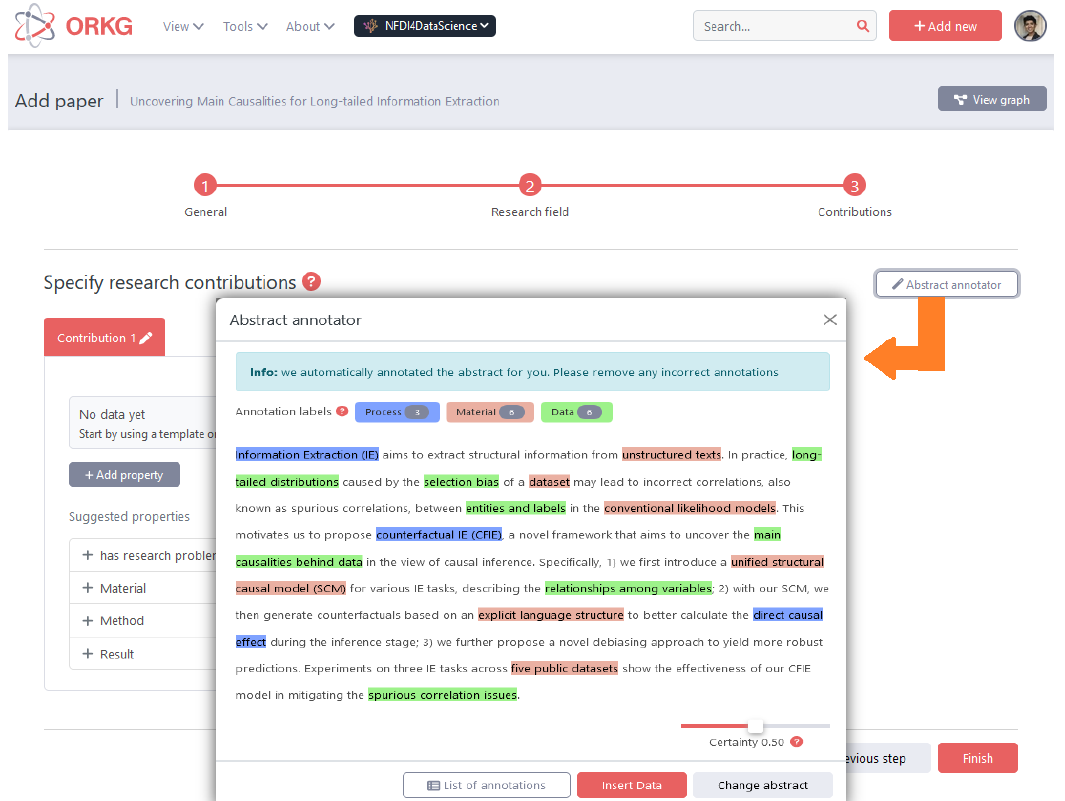
Figure 11. STEM Entities-based Abstract Annotator Recommendation Service for process, method, material, and data entities in the Add-paper wizard of the next-generation Open Research Knowledge Graph (ORKG) digital library front-end